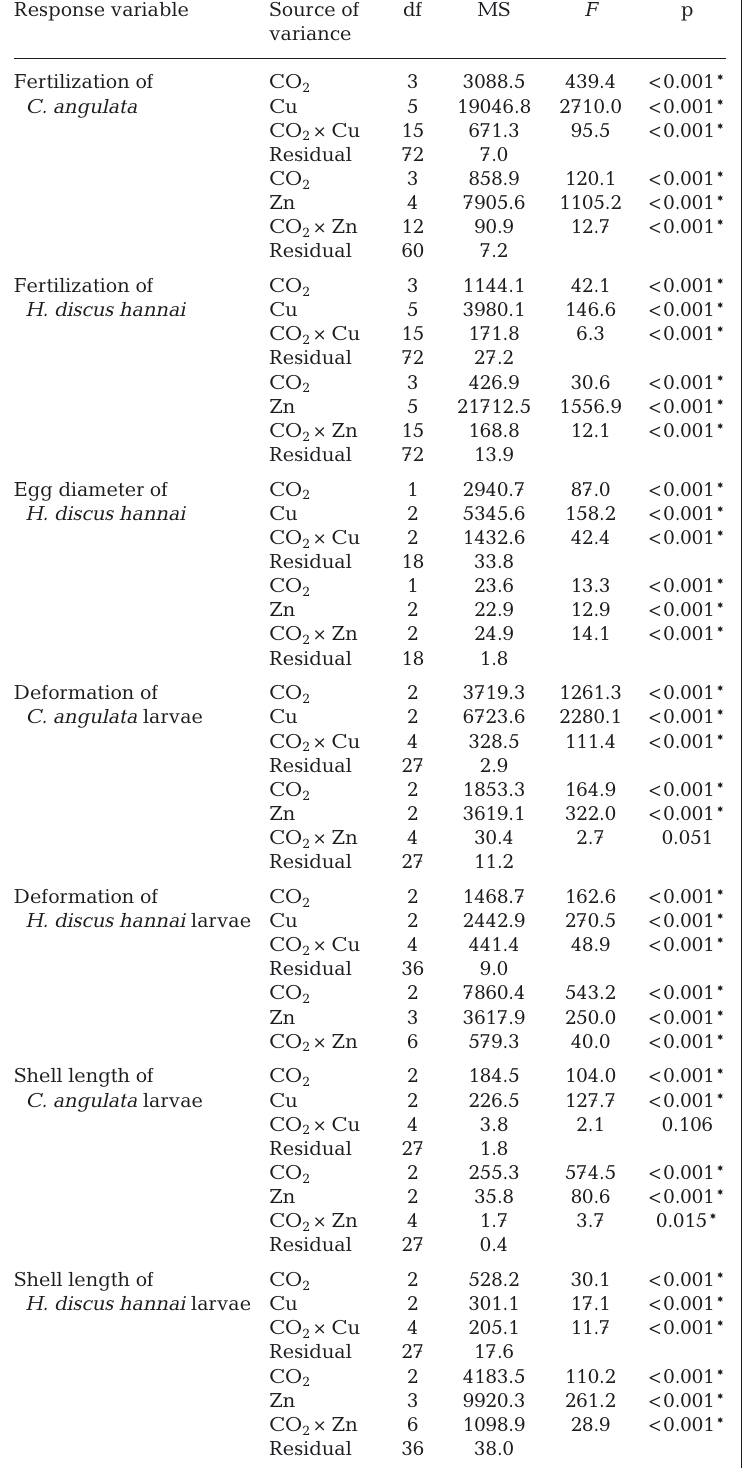
Table 2. Results of 2-way ANOVA examining the combined effects of pCO 2 and trace metals on embryonic and larval development of the oyster Crassostrea angulata and abalone Haliotis discus hannai . *p <